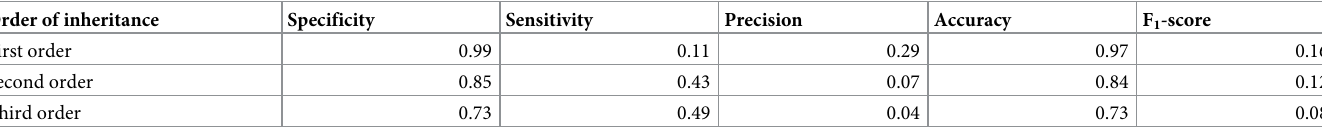
Table 1. Absolute performance measure results of first, second, and third-order inheritance. Order of